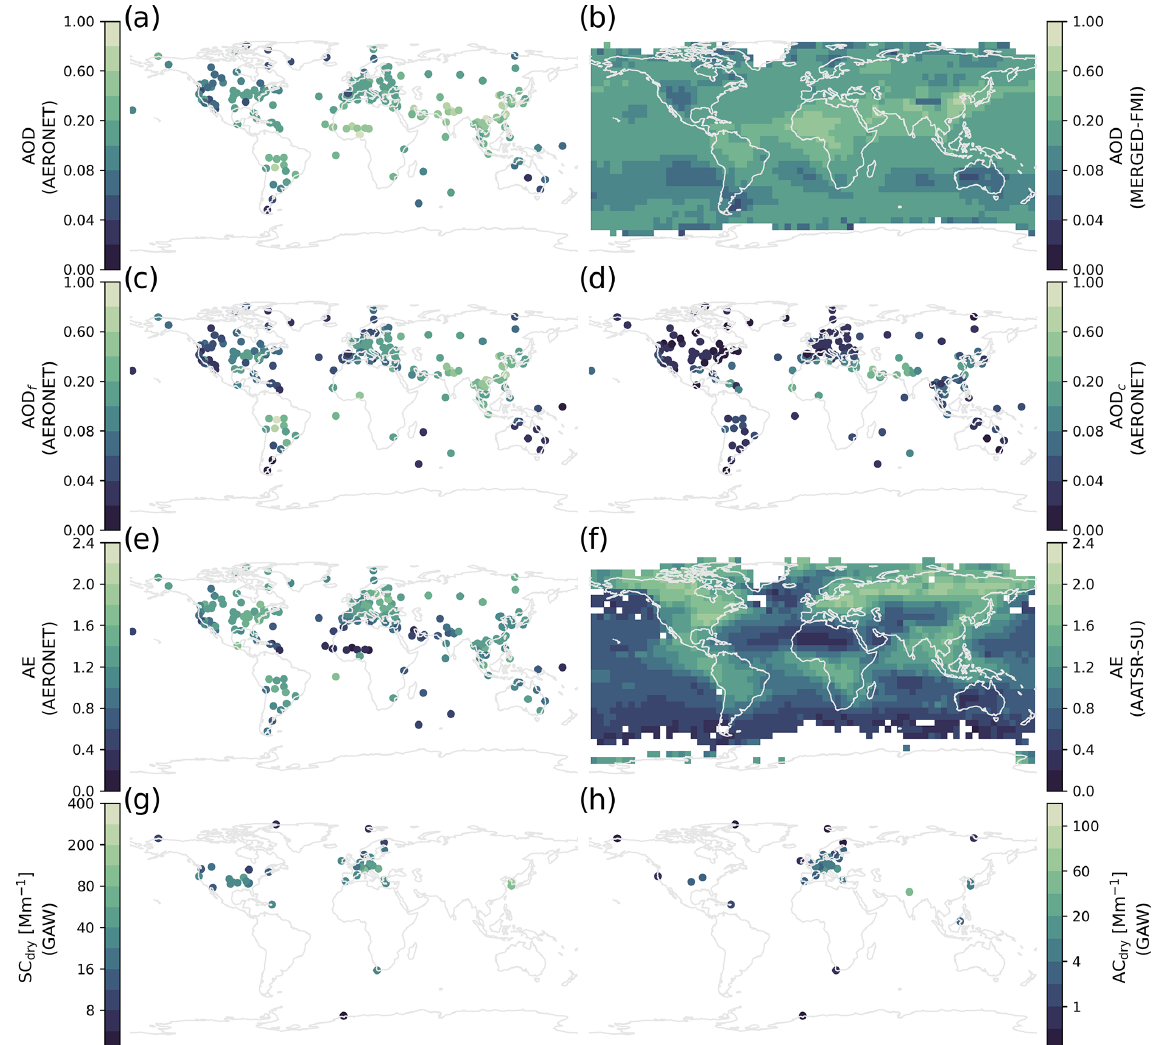
Figure 1. Overview of data used for model evaluation. Yearly averages of AODs from (a) AERONET, (b) merged satellite data set, (c) fine and (d) coarse AOD from AERONET, (e) AE from AERONET, (f) AATSR, (g) dry scattering, and (h) dry absorption coefficients from surface in situ